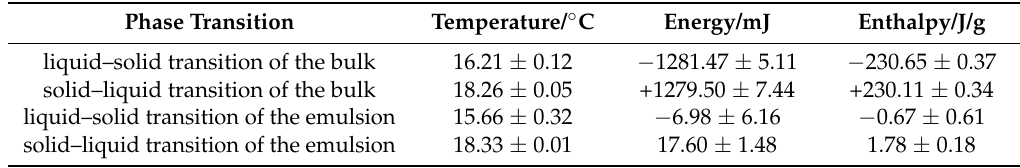
Table 1. Evaluation of phase transition onset temperature, energy and enthalpy of thermal analysis measurements of bulk hexadecane and of 1 wt % hexadecane in Milli-Q water emulsions stabilized with 1 wt % Tween ® 20 according to Figures 3 and 4.